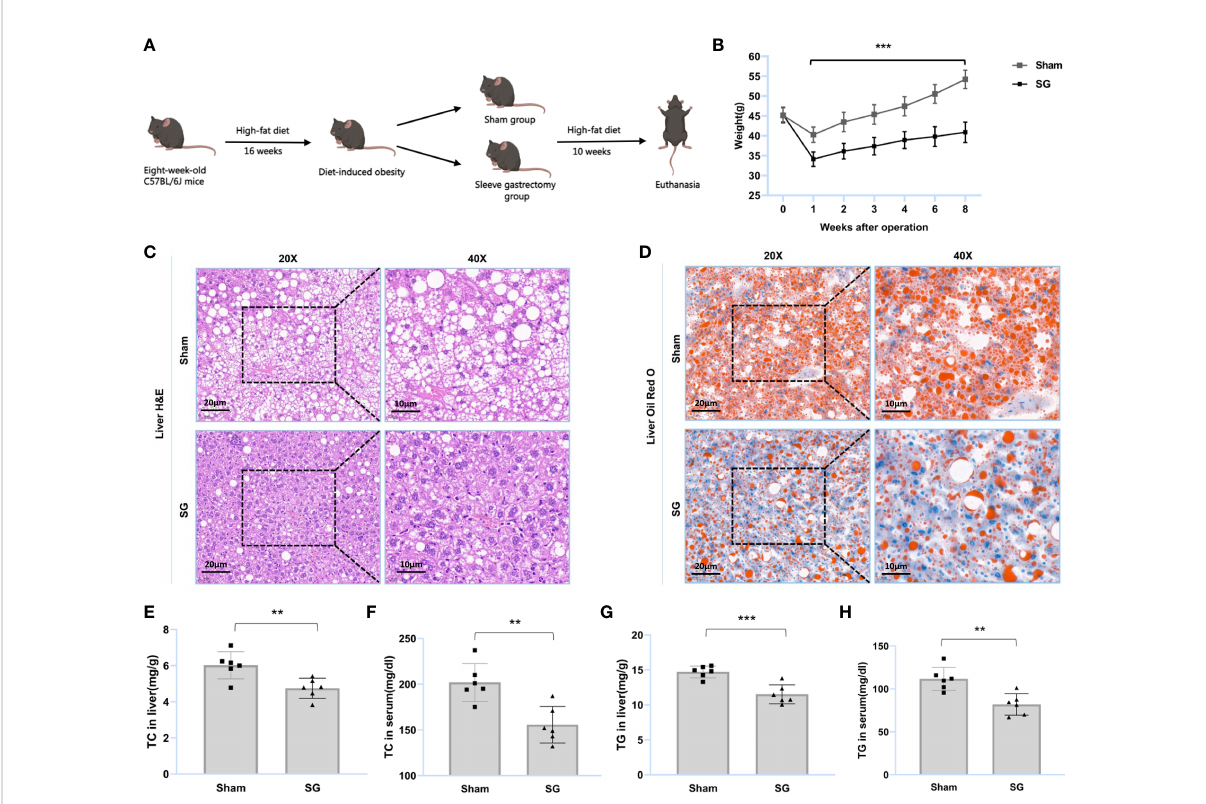
FIGURE 1 SG improves lipid dysmetabolism of DIO mice. (A) Flow diagram of SG model establishment in DIO mice. (B) Body weight after surgery (n = 6). (C, D) H&E and Oil Red O staining of liver tissue from sham and SG group. Scale bars were shown in the fi gure. (E, F) Liver and serum TC levels of sham and SG group (n = 6). (G, H) Liver and serum TG levels of sham and SG group (n = 6). The data are expressed as mean ± SEM, Student ’ s t-test was used for intergroup comparisons. **p < 0.01, ***p <